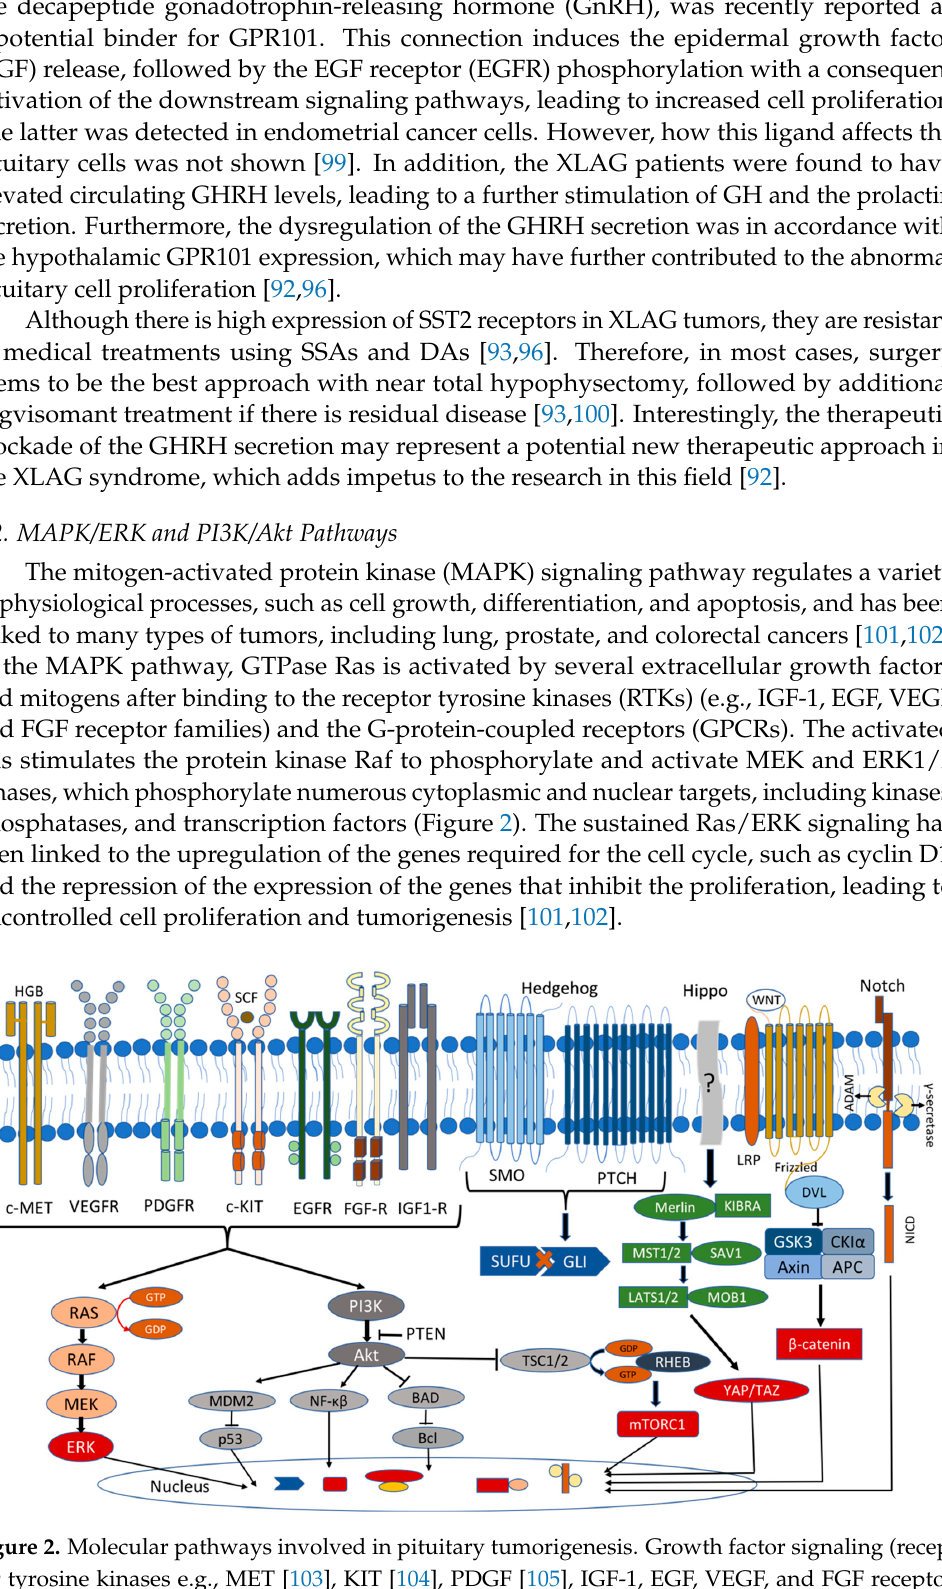
death; TSC: tuberous sclerosis complex1/2; RHEB: Ras homolog enriched in brain; mTORC: mecha- nistic target of rapamycin; SMO: smoothened; PTCH: protein patched homolog 1; SUFU: suppressor of fused homolog; Gli: glioma-associated oncogene homologue; MST1/2: mammalian sterile 20-like